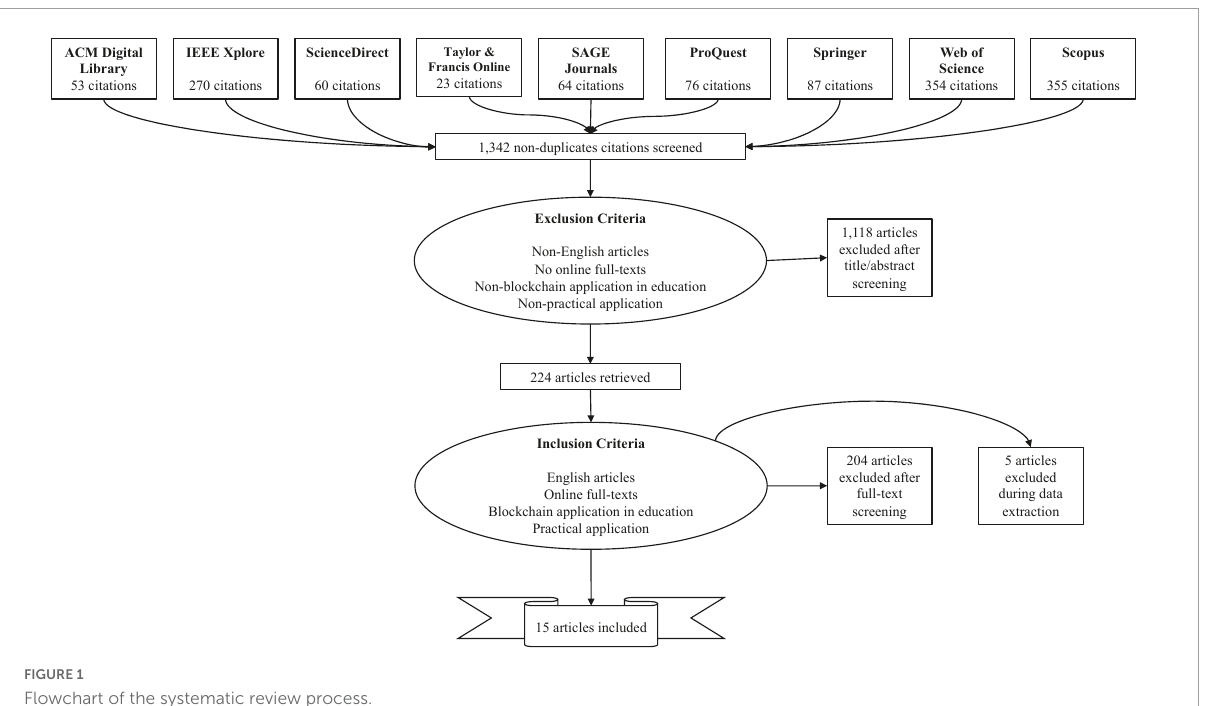
FIGURE1 Flowchart of the systematic review